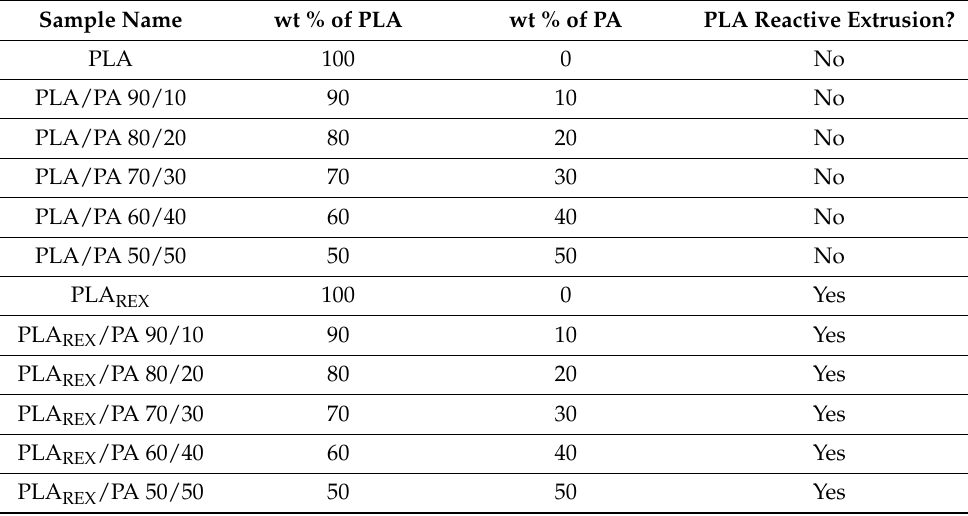
Table 1. Compositions of materials with or without reactive extrusion of